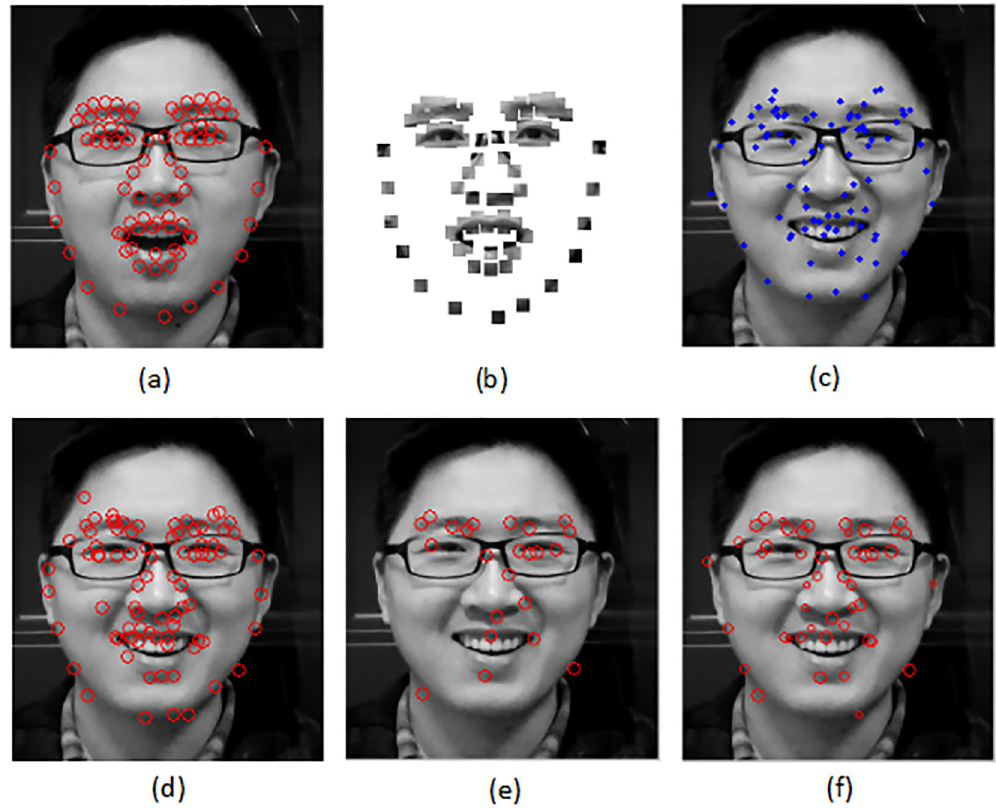
Fig 1. Local matching results. (a) The template image and landmarks. (b) The patch representation of (a). A 9 × 9 patch is set around each landmark. (c) The target image with initial landmark. (d) The local matching results by NN. (e) The local matching results by 1-PP (KPP, K = 1). (f) The local matching results by 5-PP (KPP, K = 5). The size of the circle presents the weight